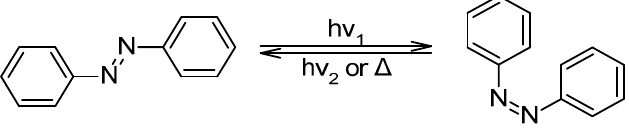
Figure 3. Azobenzenes and their switch